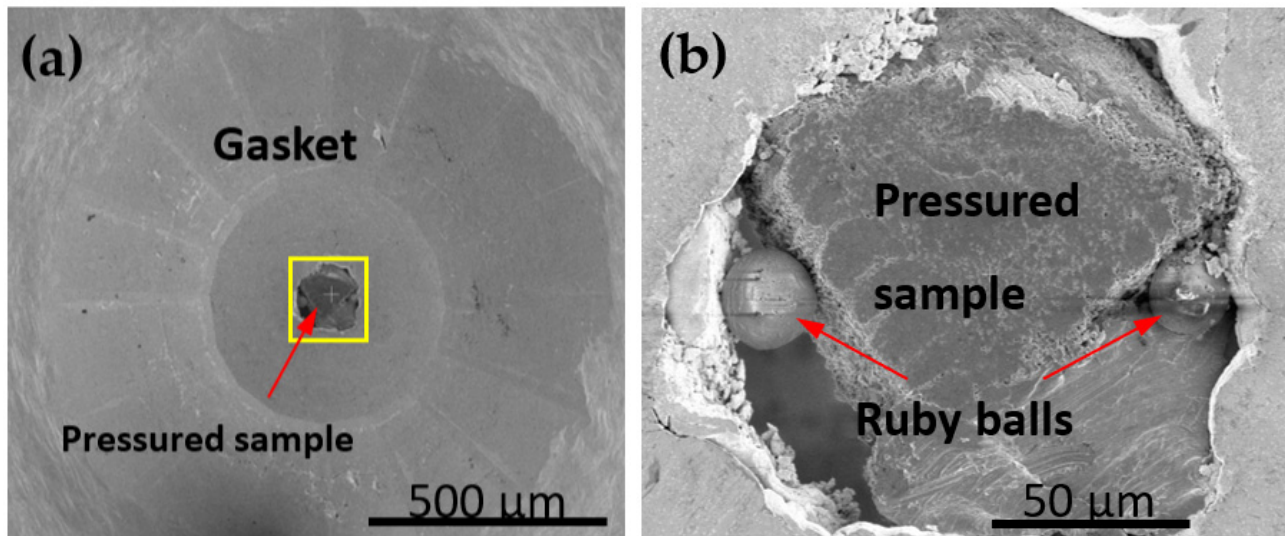
Figure 2. Samples used for ex situ microscopy studies after withdrawing these from high pressure tests. ( a ) Specimen placed inside the membrane as it was during high pressure experiments. ( b ) Enlarged view of yellow box region in ( a ) showing the arrangement of sample supported by Ruby balls in either side to hold it inside the gasket hole.